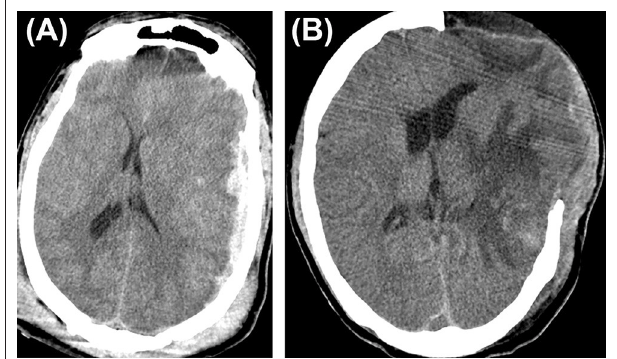
FIGURE 2 | Cerebral herniation. (A) A case of traumatic brain injury depicting cerebral herniation (B) from the craniectomy site.